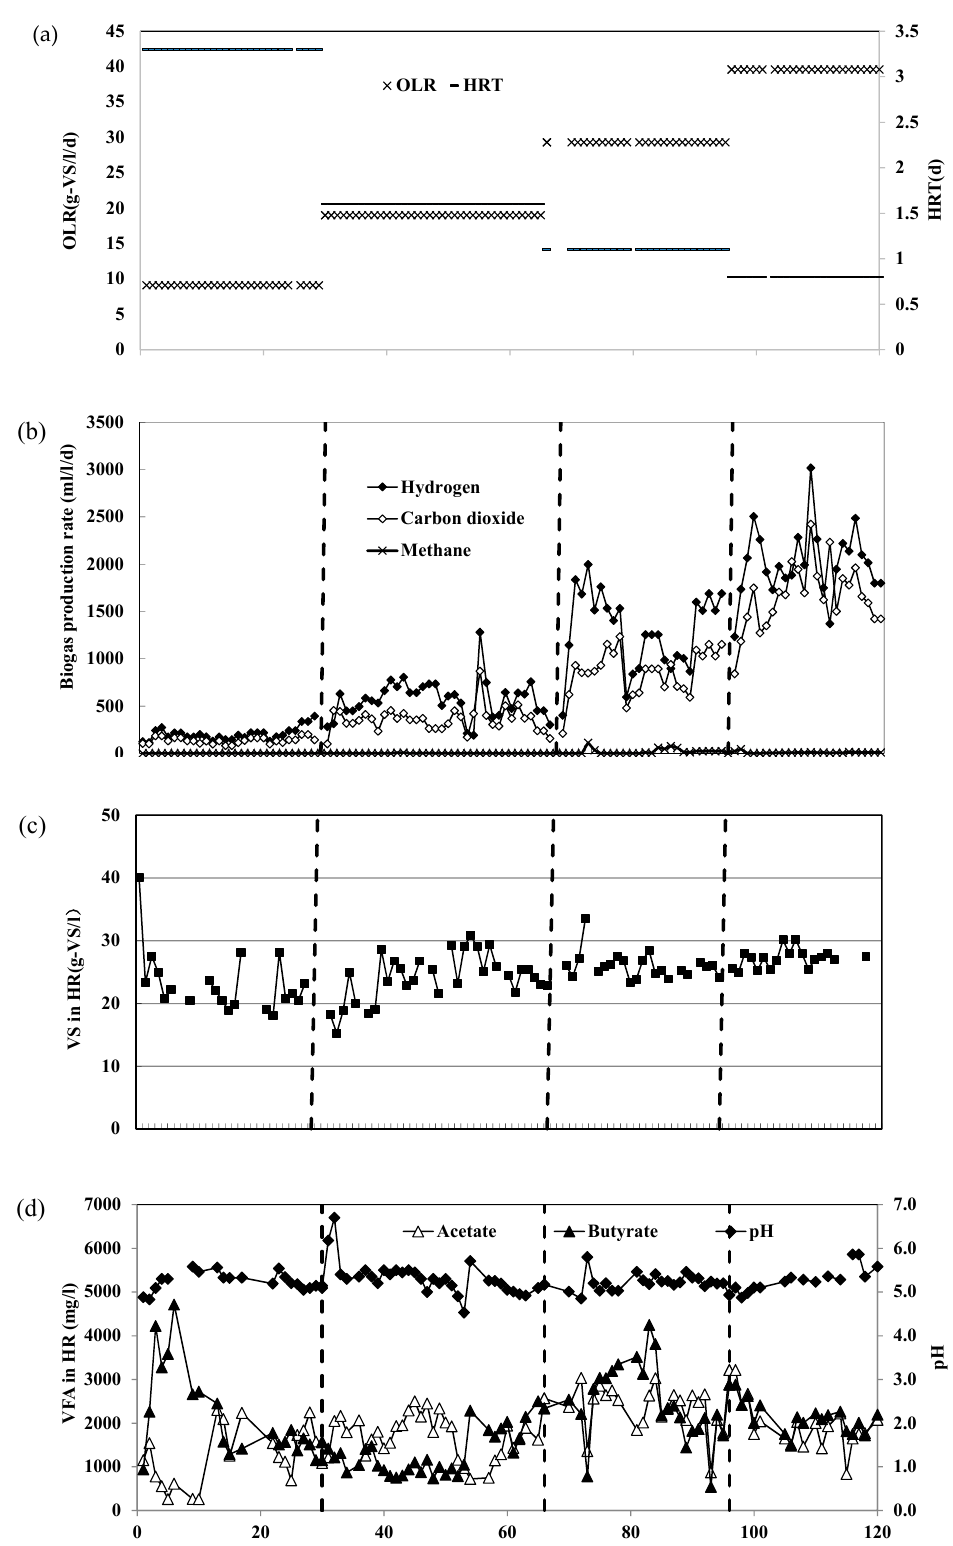
Figure 2. Time courses of biogas production rate, volatile solid (VS), pH, acetate and butyrate in H 2 -reactor (HR) at various hydraulic retention times (HRT) and organic loading rates (OLR). ( a ) HRT and OLR conditions in HR; ( b ) Hydrogen, carbon dioxide and methane production rates in HR; ( c ) VS concentration in HR; ( d ) Acetate content, butyrate content and pH in HR.